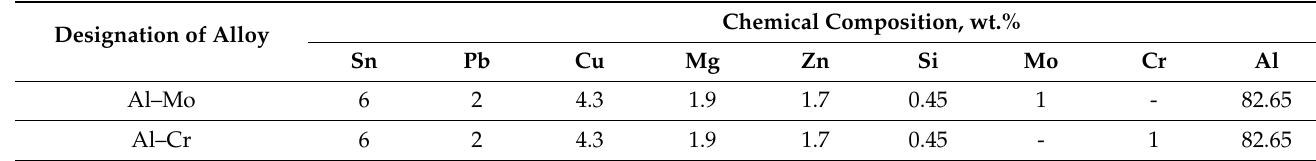
Table 1. Nominal chemical composition of studied